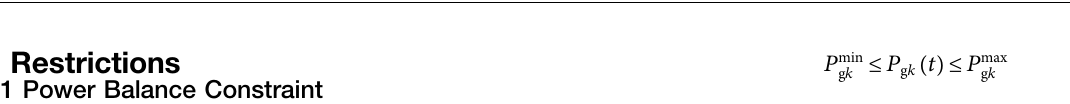
Frontiers in Energy Research |